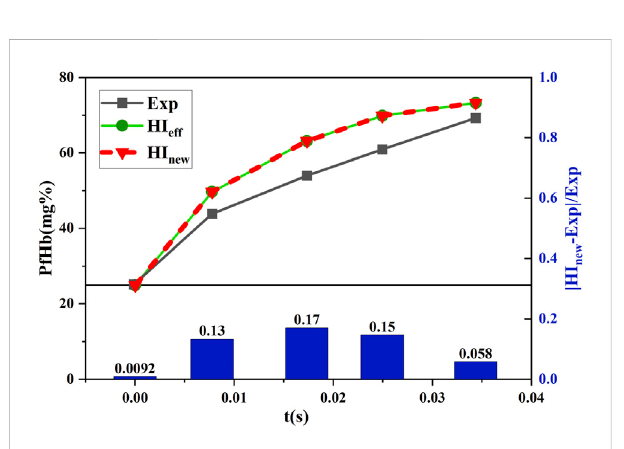
FIGURE 10 Comparison between the estimated and experimental hemolysis values with the increasing shear force under time working